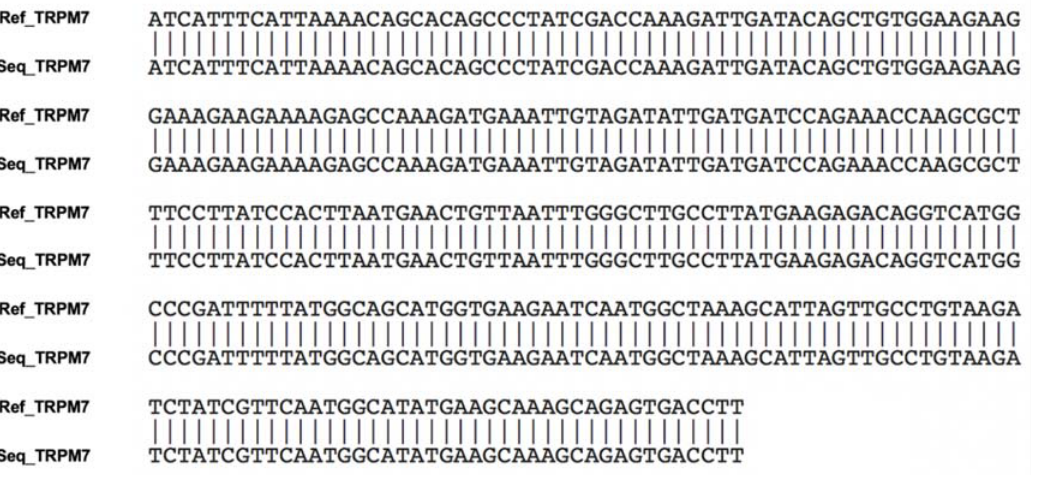
Figure 2. Nucleotide sequences of the amplified PCR products. Ref_TRPM7 indicates the TRPM7 sequences obtained from the National Center for Biotechnology Information sequence database. Seq_TRPM7 indicates the TRPM7 sequences obtained using RT-PCR in the present study. Each nucleotide sequence matched the expected sequences of canine TRPM7.